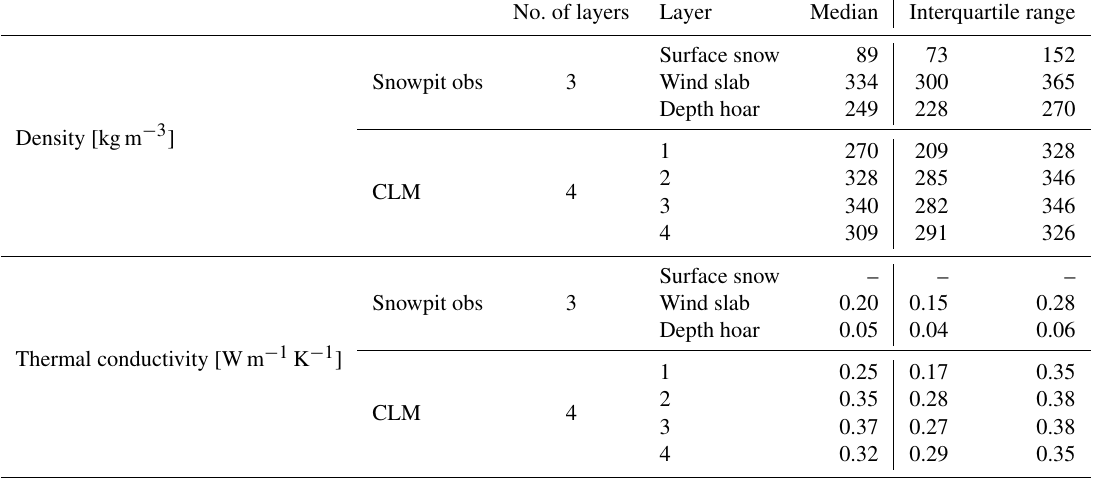
Table 2. Summary of modelled (CLM) and measured snow densities and thermal conductivities (from the manual density profiles and the needle probe